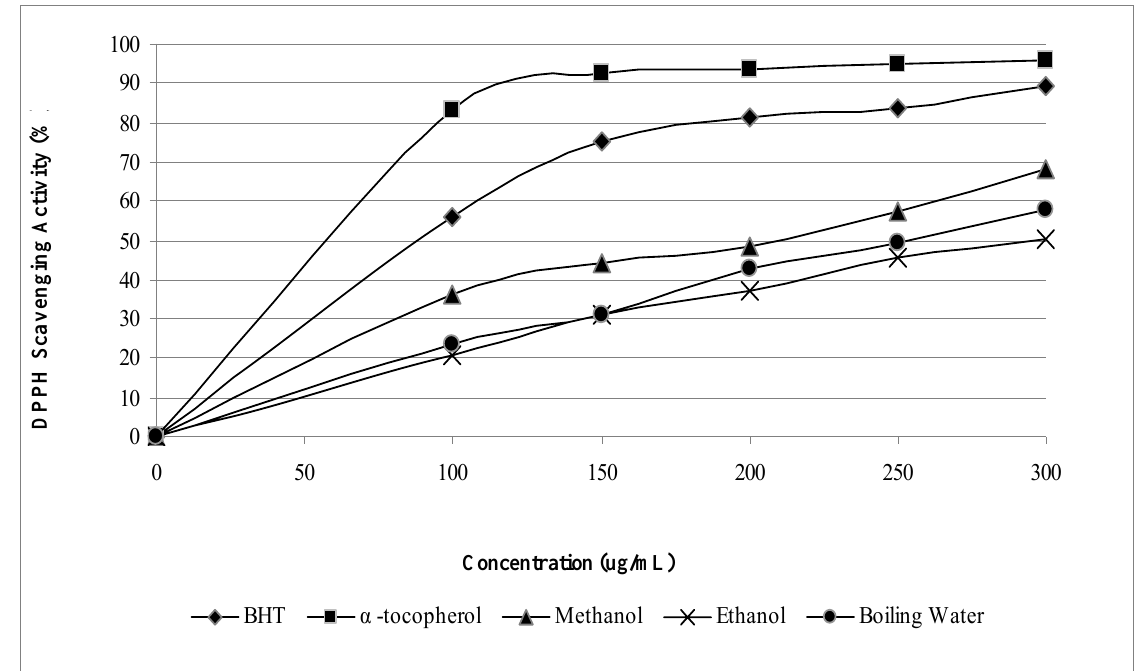
Figure 1. Free radical scavenging activity of Crocus sativus extracts and reference antioxidants.